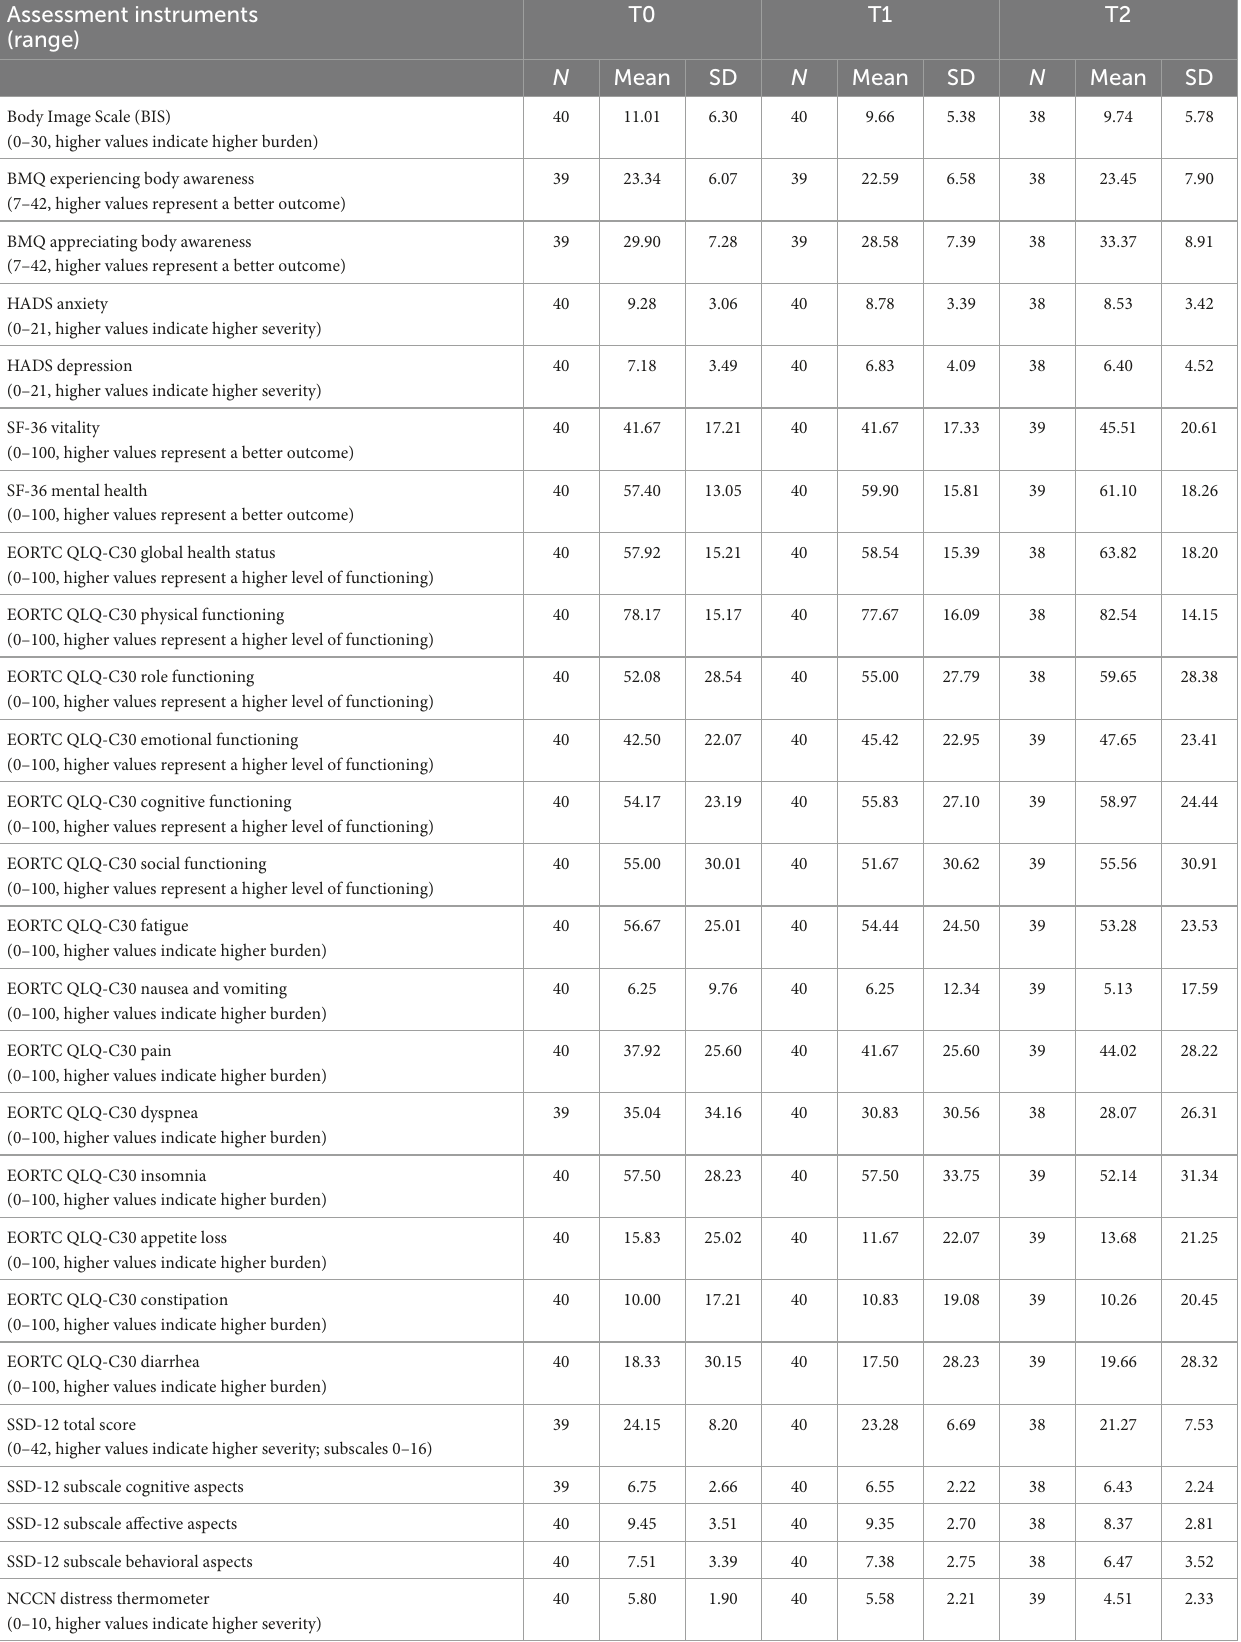
TABLE 2 Summary statistics of all primary and secondary outcomes at all three time points. Assessment instruments